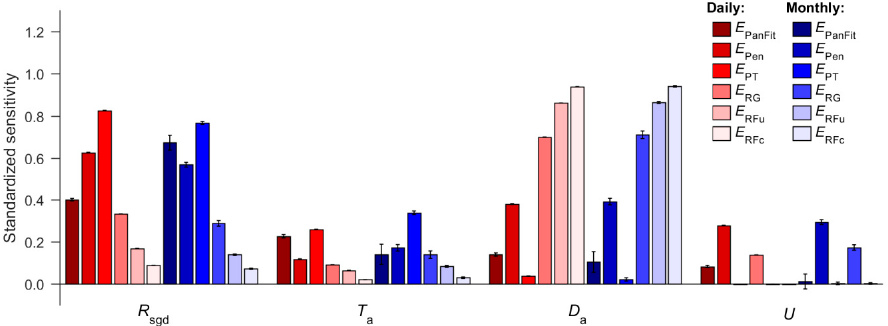
Figure 5. The sensitivity of potential evaporation (PE) to driving variables on a daily and monthly time scale. Left-to-right (red bars): Fixed effects from linear mixed-effects model fits to daily pan evaporation ( E PanFit ); fixed effects from model fits to daily predictions of PE from Penman’s model; fixed effects from model fits to daily predictions of PE from the Priestley–Taylor model; fits to daily reference evaporation from grasslands based on the Penman–Monteith model; fits to daily reference evaporation from forest canopies that are moderately coupled to the atmosphere based on the Penman–Monteith model; fits to daily reference evaporation from forest canopies that are well coupled to the atmosphere based on the Penman–Monteith model. Blue bars then repeat through the same estimates, only for fits to monthly instead of daily time scale.